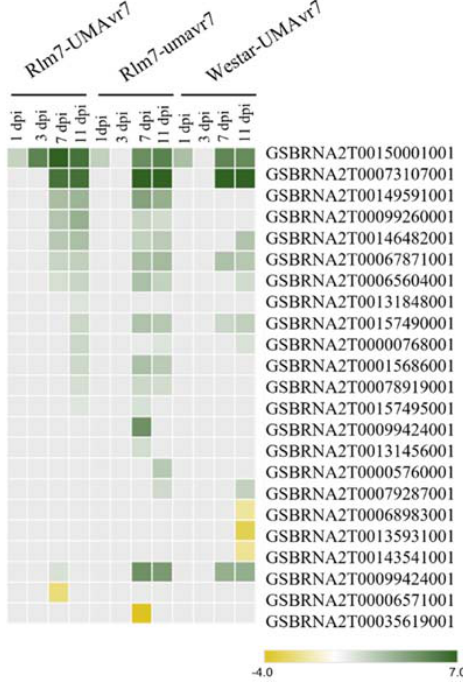
Figure 11. Differential expression of genes related to salicylic acid biosynthesis and signaling pathways. Rlm7-umavr7, Rlm7-umavr7, and Westar-UMAvr7 interactions are shown. Logarithm of absolute value of the fold-change cutoff (logFC) ≥ 2, and false discovery rate (FDR) ≤ 0.05 were considered.